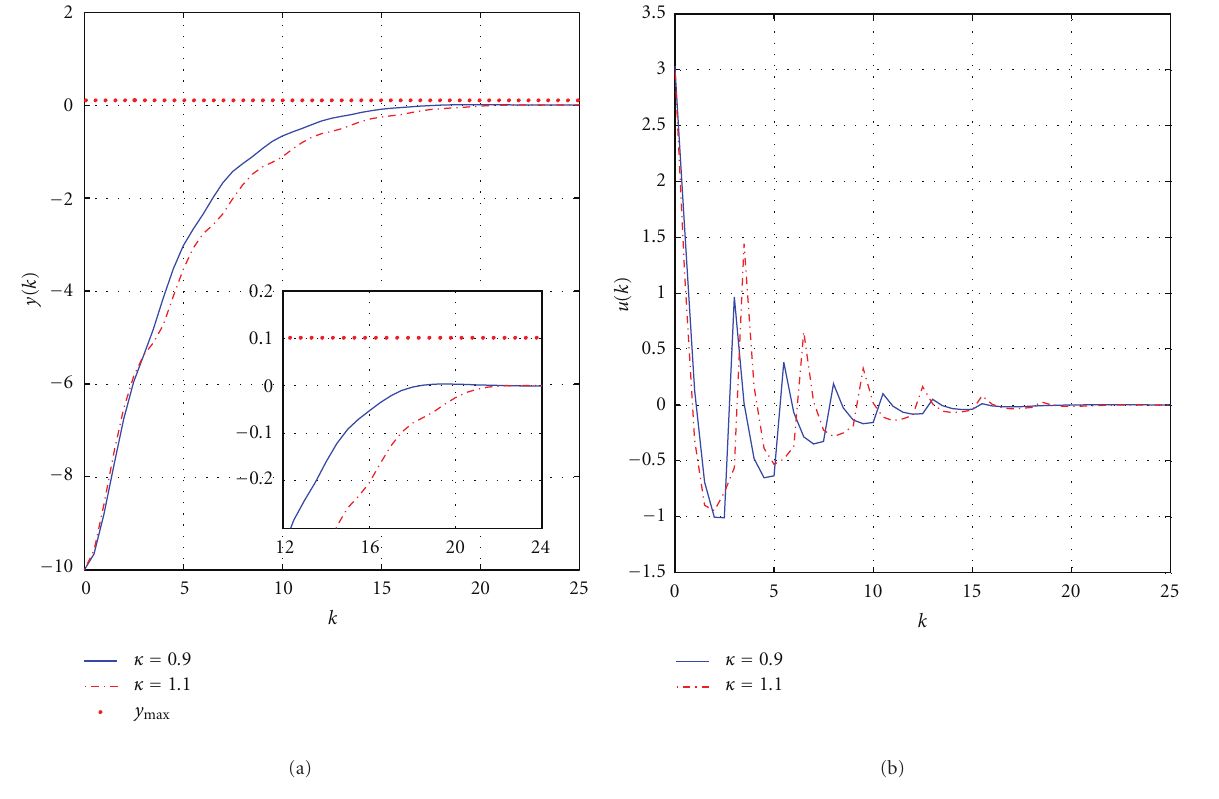
Figure 5: Simulation results using the proposed strategy: (a) output and (b) control signals.